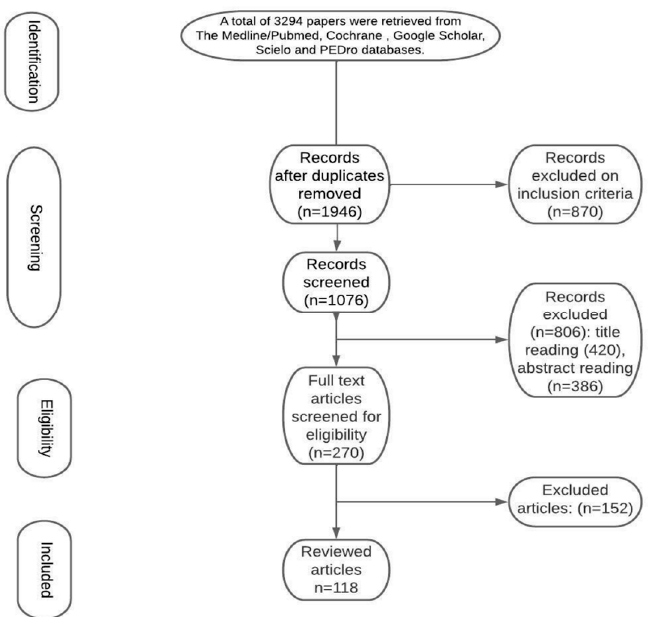
Figure 1. Flow diagram representing our process for article selection.